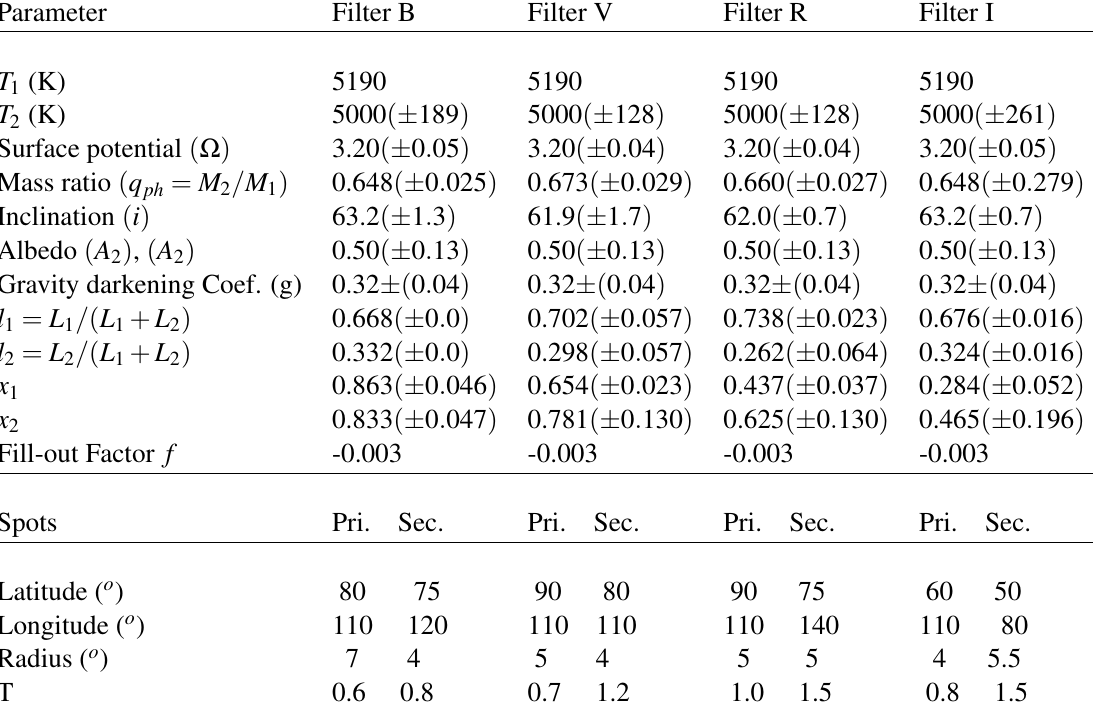
Table 3 The light curve fit parameters by PHOEBE for GSC